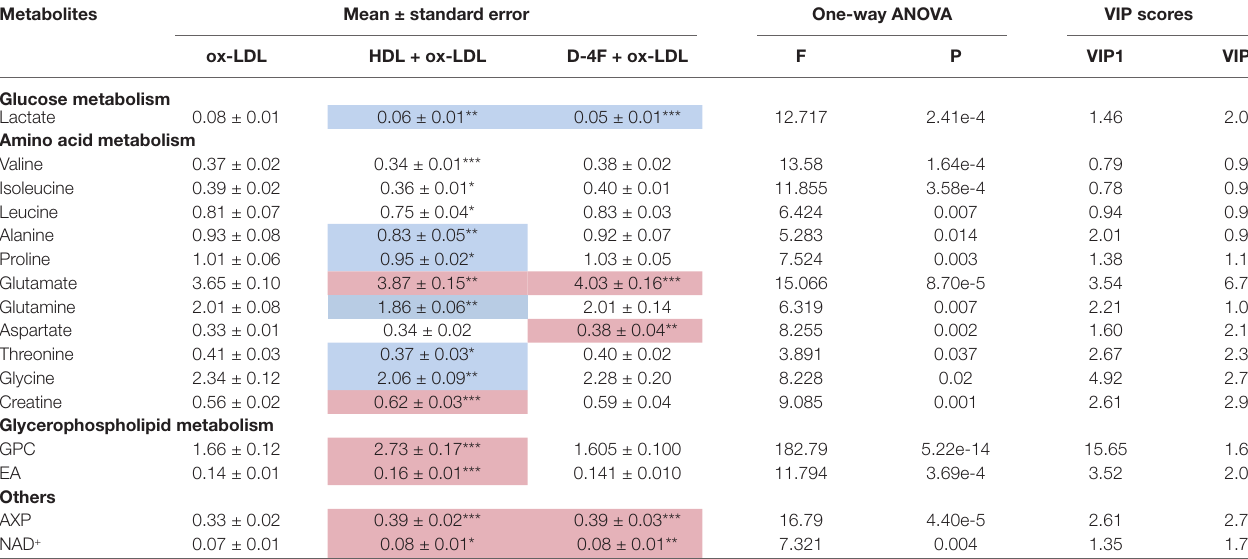
TABLE 1 | Quantitative analysis of characteristic metabolites among the ox-LDL, HDL + ox-LDL, and D-4F + ox-LDL groups. Metabolites